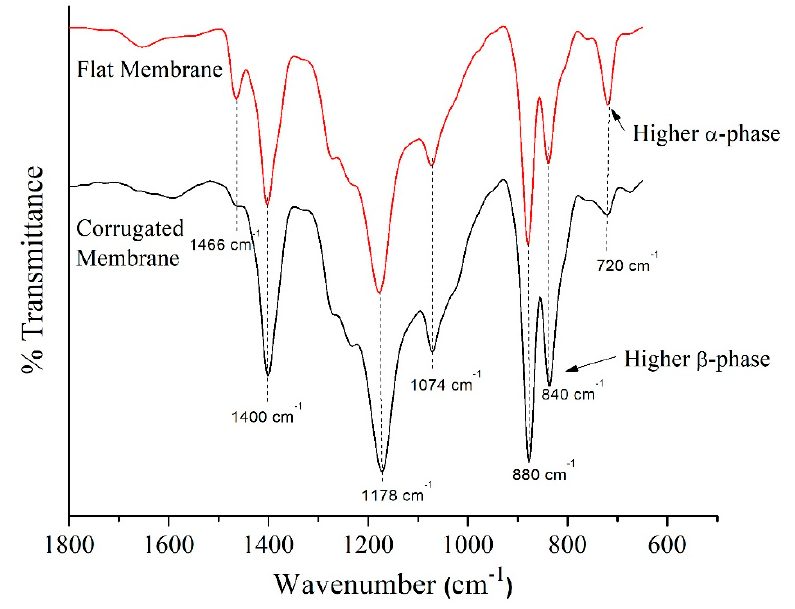
Figure 5. The FTIR spectra of the developed flat and corrugated PVDF membranes.